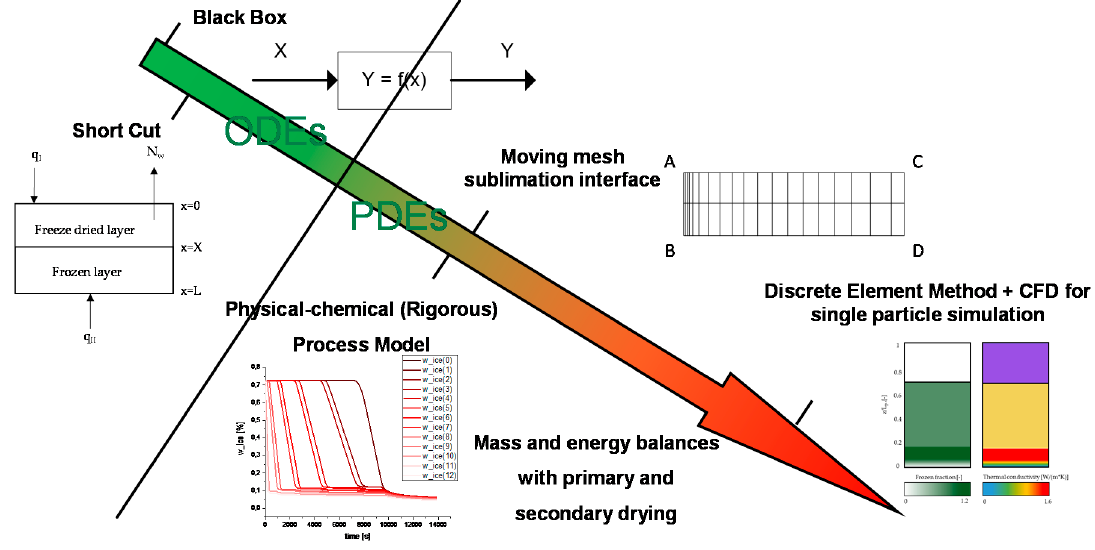
Figure 7. Model depth for some models from literature (Pictures adapted from [42,62,72]).